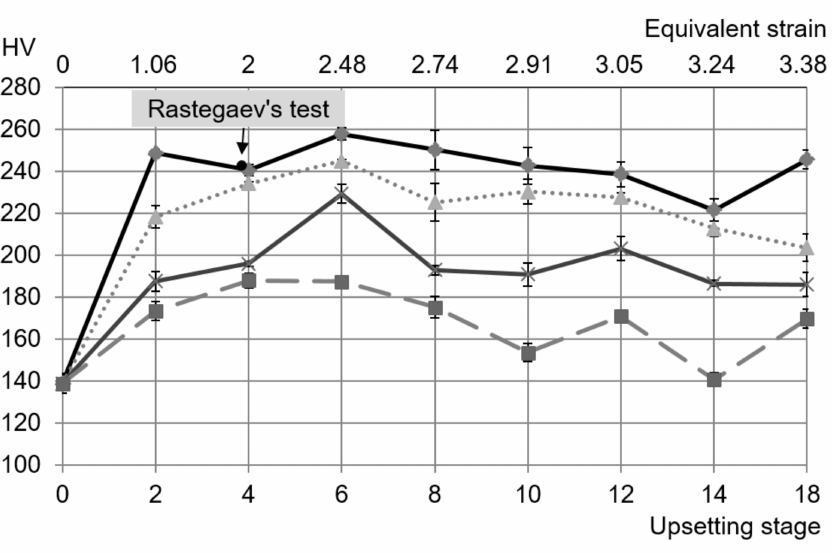
Figure 13. Dependence of microhardness on the process stage at several locations ( c -axis, —2 mm from c -axis, —4 mm from c -axis, —6 mm from c -axis).